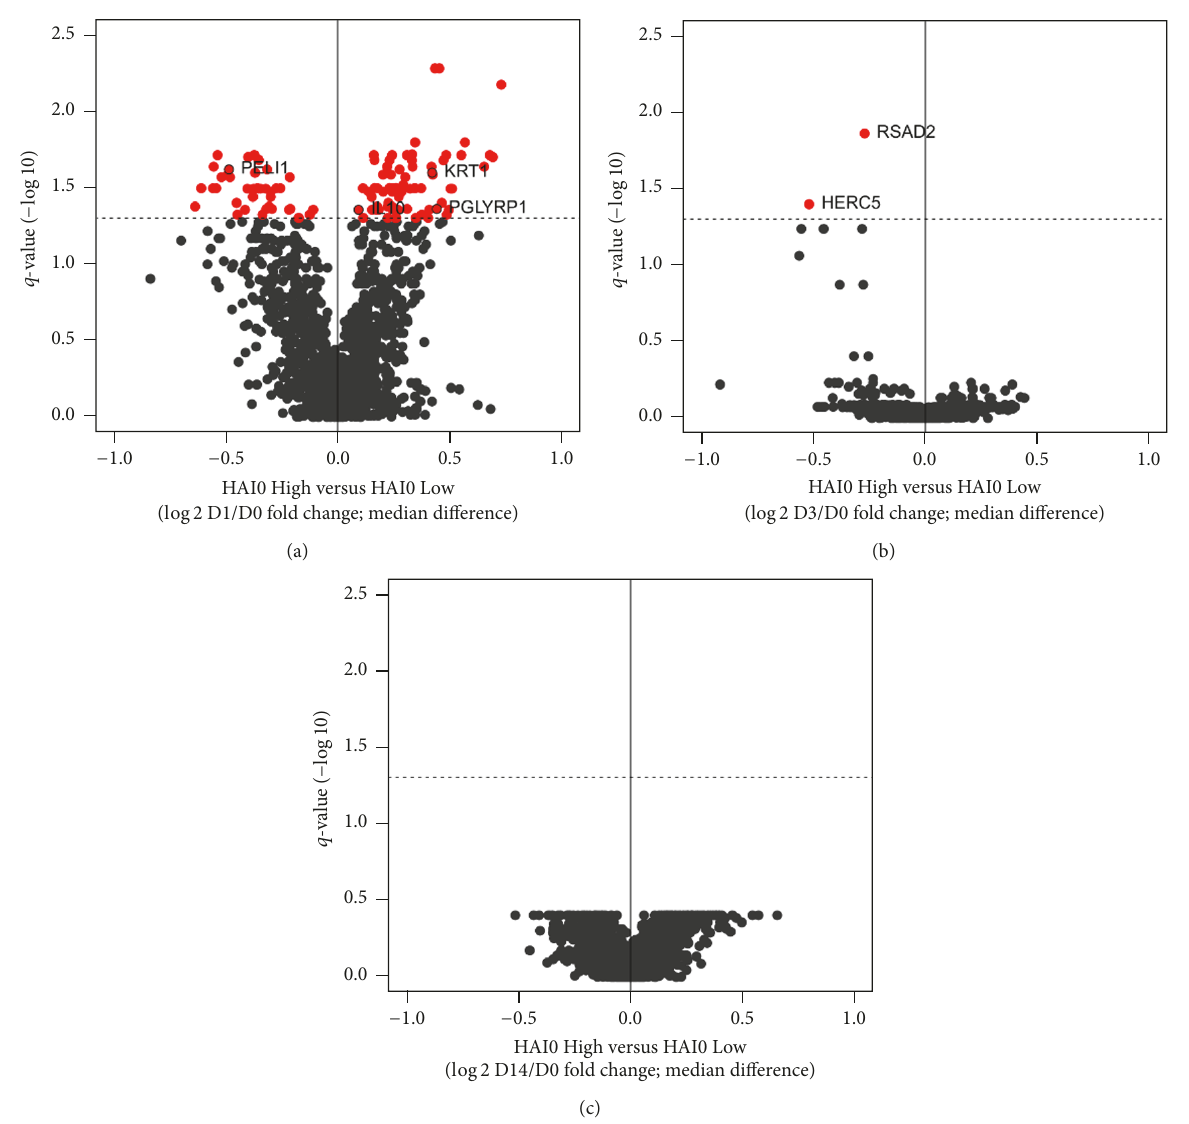
Figure 4: Differentially responsive genes in subjects with low and high preexisting immunity to the influenza vaccine, set #4. Volcano plots showing the differences in gene responsiveness (fold change from baseline) between subjects with high (High) and low (Low) baseline antibody titers (HAI Day 0 ). 𝑌 -axes represent the 𝑞 -values computed by adjusting Wilcoxon test 𝑝 values using the Benjamini-Hochberg procedure. 𝑋 -axes represent the difference in the median fold change from baseline response between subjects with high and low baseline immunity. Results are reported for day 1 (a), day 3 (b), and day 14 (c) time points.